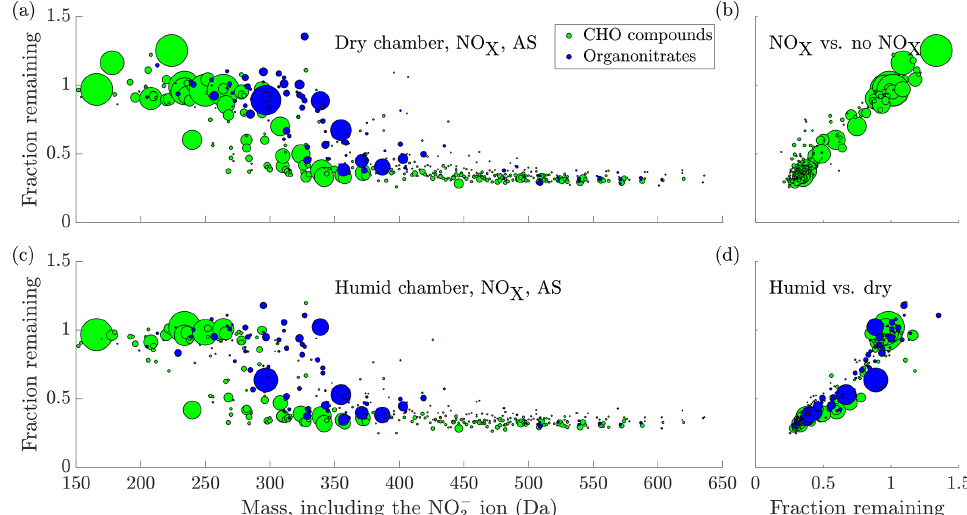
Figure 6. (a) The fraction remaining after seed injection vs. the molecular mass of the detected cluster, including the charging NO − The area of the circles is scaled linearly to the magnitude of the signal of each compound before the seed injection, capped at 3 . 2 × 10 − 3 . The data are the average of experiments 15 and 19, with ammonium sulfate injection to dry chamber, in the presence of NO x . Compounds with a signal-to-noise ratio, as defined in Sect. 2.7, below 4 have been excluded from the plot. (b) Comparison of the experiment in (a) to the no NO x case in Fig. 5. The y axis and circle size are the same as in (a) , with the fraction remaining from Fig. 5 on the x axis. Only CHO compounds are plotted, as organonitrates are not formed in the experiments without NO x . There is a general linear agreement between the two experiment types, indicating that the addition of NO x did not significantly influence the behaviour of non-nitrates upon seed addition. (c) same as (a) , but in humid conditions (experiment 18, 40% RH and deliquesced seed). (d) the same as (b) , but comparing the experiments in (a) and (c) : (a) in the x axis and (c) in the y axis. The values for the fraction remaining for both organonitrates and CHO compounds are consistently lower in the humid case, indicating enhanced uptake in those conditions. In (c) and (d) , the y axis has been cut at 1.5 for clarity, excluding the compound C 5 H 6 O 6 at mass 224 with a fraction remaining of